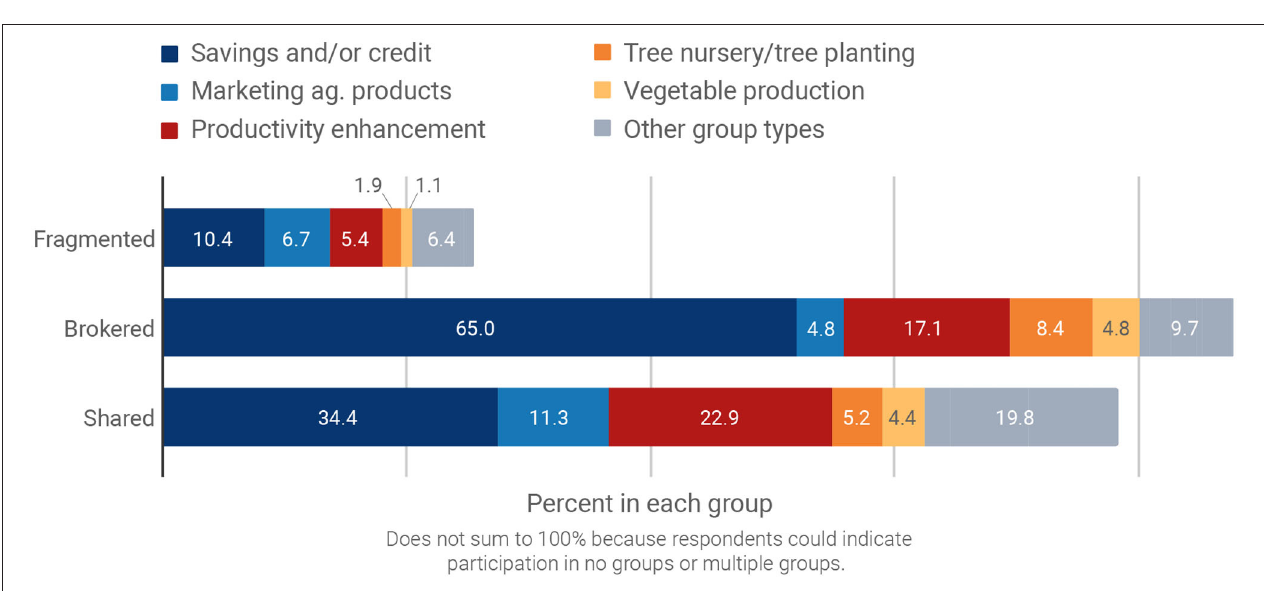
FIGURE 3 | Group prevalence across community network types. These five groups represent the majority of household group memberships. Full details of all group memberships in Supplementary Table 1